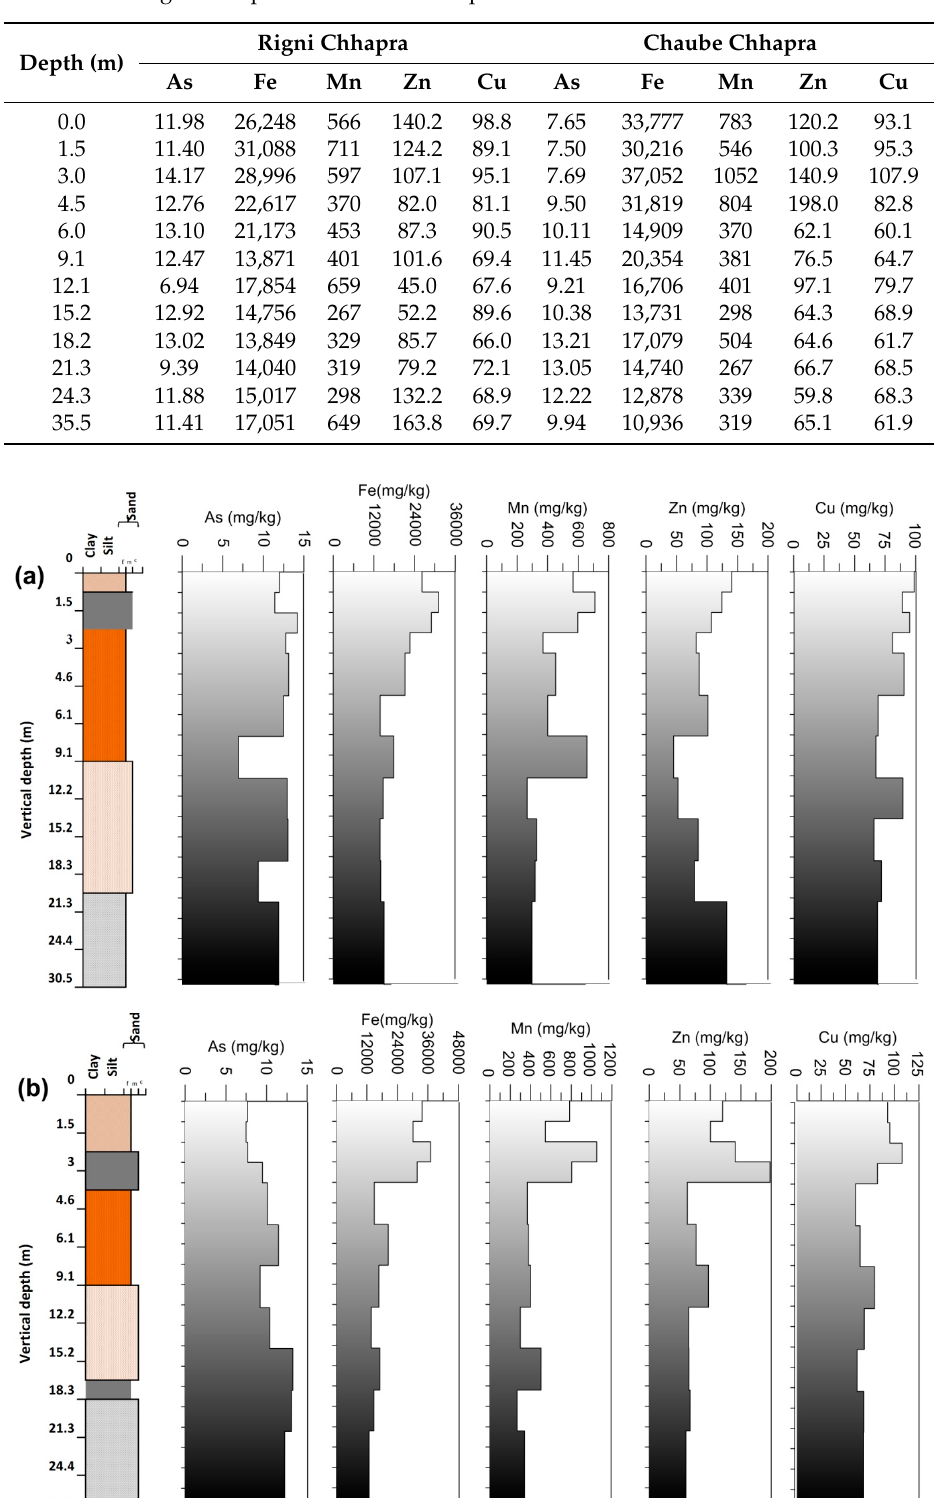
Table 2. The concentration of As and other elements in (mg/kg) dry wt. extracted from core sediments vertical below at Rigni Chhapra and Chaube Chhapra.